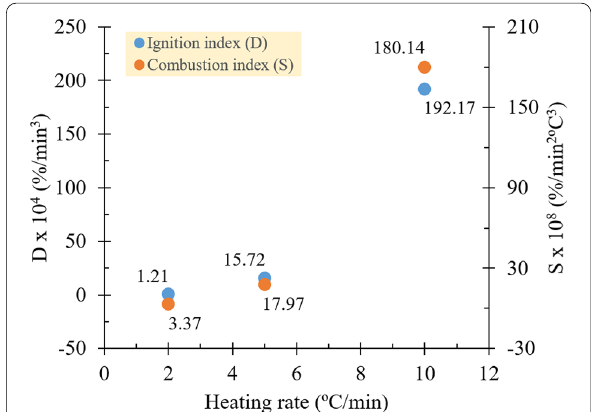
Fig. 4 Effects of different heating rates on the ignition and combustion indices